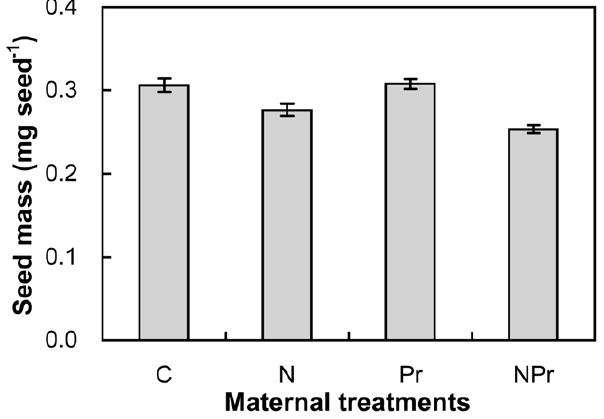
Figure 2. Effects of maternal-treatments on seed mass (mg seed 2 1 ) of Potentillatanacetifolia . Data are mean 6 SE (n=5). See Figure 1 for abbreviations.